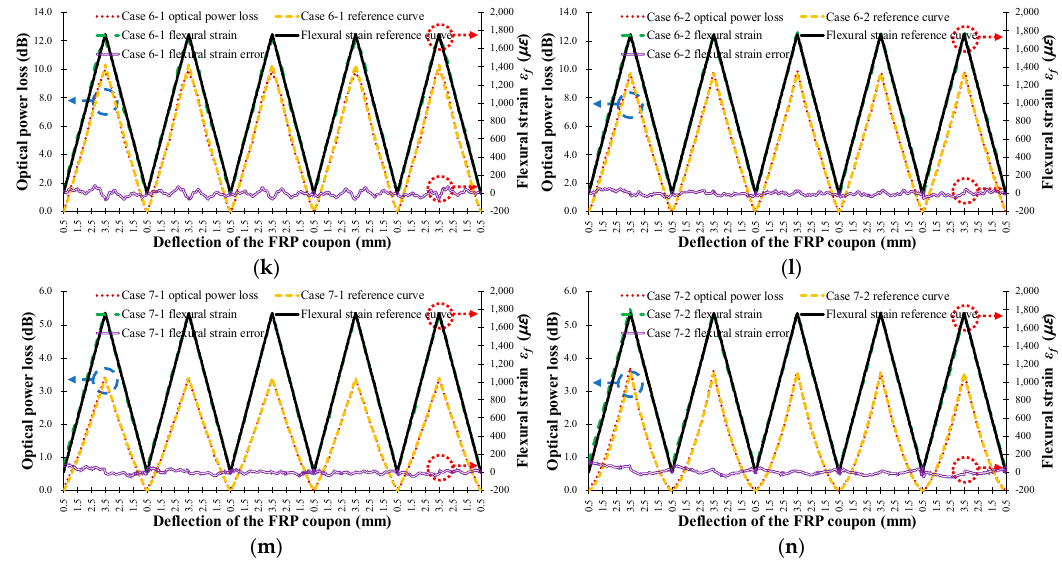
Figure 12. Measured FOS head optical power loss ( left ), measured flexural strain, and calculated flexural strain error ( right ) according to the deflection of the FRP coupon for the seven types of FRP sensor head in Table 1. ( a ) Case 1-1; ( b ) Case 1-2; ( c ) Case 2-1; ( d ) Case 2-2; ( e ) Case 3-1; ( f ) Case 3-2; ( g ) Case 4-1; ( h ) Case 4-2; ( i ) Case 5-1; ( j ) Case 5-2; ( k ) Case 6-1; ( l ) Case 6-2; ( m ) Case 7-1; ( n ) Case 7-2.